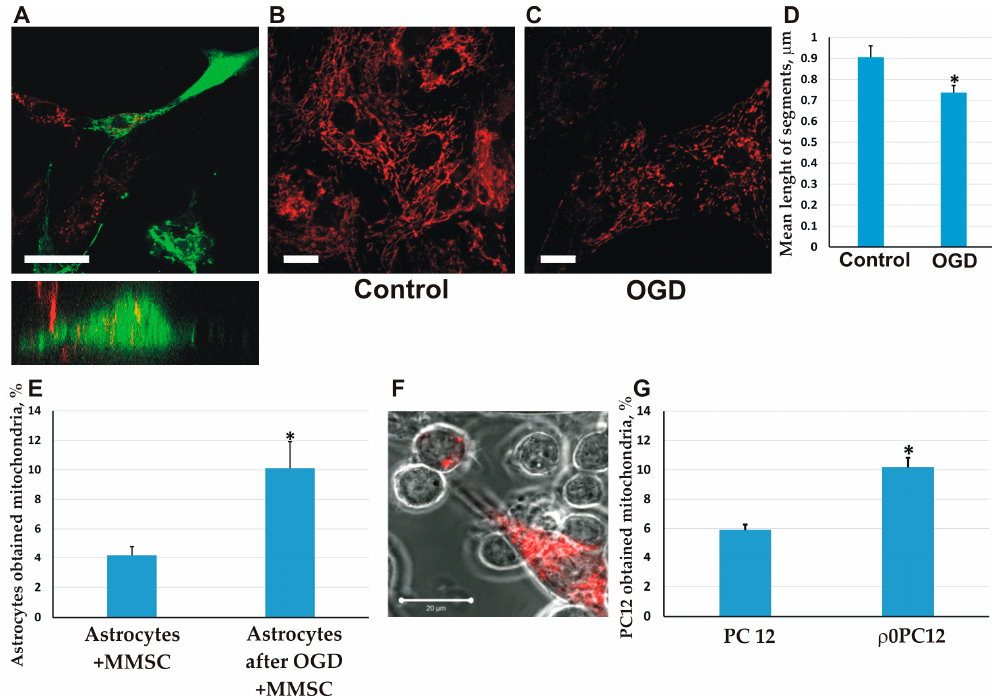
Figure 1. The transfer of mitochondria from MMSC to astrocytes and neural cells following mitochondrial damage. ( А ) Mitochondrial transfer from MMSCs to astrocytes. DsRed-labeled mitochondria from MMSC were transferred to astrocytes with GFP-labeled mitochondria. The intracellular location of red fluorescence was confirmed using confocal line-scanning microscope analysis of cells along the z -axis (bottom); ( B – D ) Mitochondrial fragmentation in astrocytes stained with TMRE (tetramethylrhodamine, ethyl ester) after 5 h of oxygen-glucose deprivation (OGD). Averagely shorter mitochondrial fragments ( D ) supports mitochondrial fragmentation; ( E ) The efficacy of mitochondrial transfer from MMSC to astrocytes is increased after OGD; ( F ) The transfer of DsRed-labeled mitochondria from ММСК to ρ 0 PC12 cells; ( G ) MMSCs more efficiently transferred mitochondria to ρ 0 PC12 cells than to native PC12 cells. Scale bars = 10 µm ( A , B ), and 20 µm ( F ). All experiments were performed at least in triplicate; * denotes significant differences between groups ( p < 0.05) (One-way ANOVA, followed by Tukey’s post hoc analysis). Values are given as mean ± standard error of the mean (SEM).